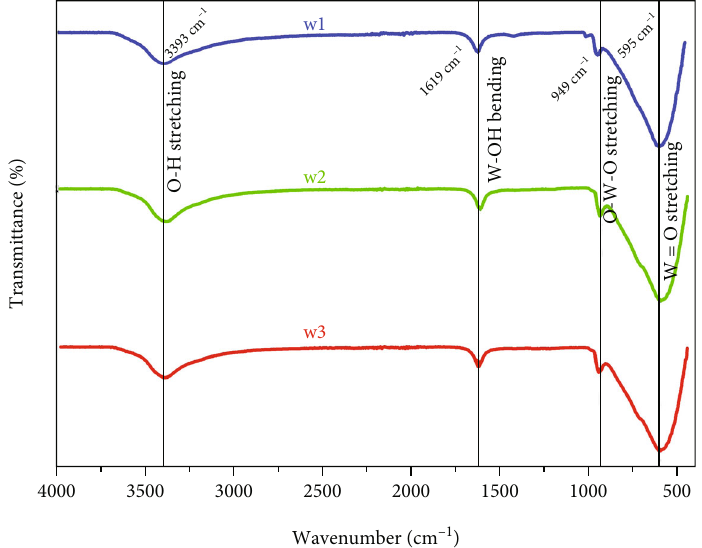
Figure 4: FT-IR spectrum of WO